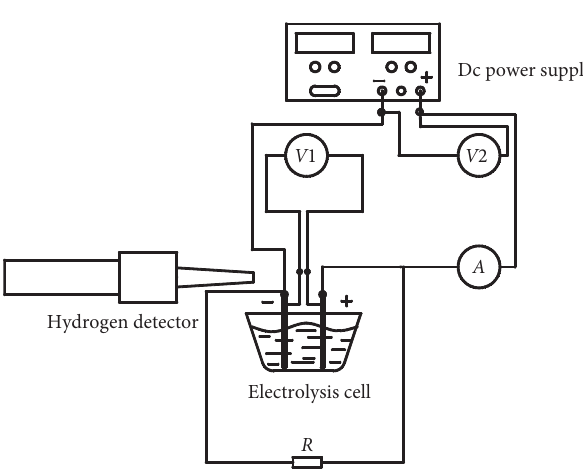
Figure 2: Diagram of experimental setup: V 1, measuring cell voltage; V 2, measuring supply voltage; A , measuring circuit cur- rent; R , resistor.